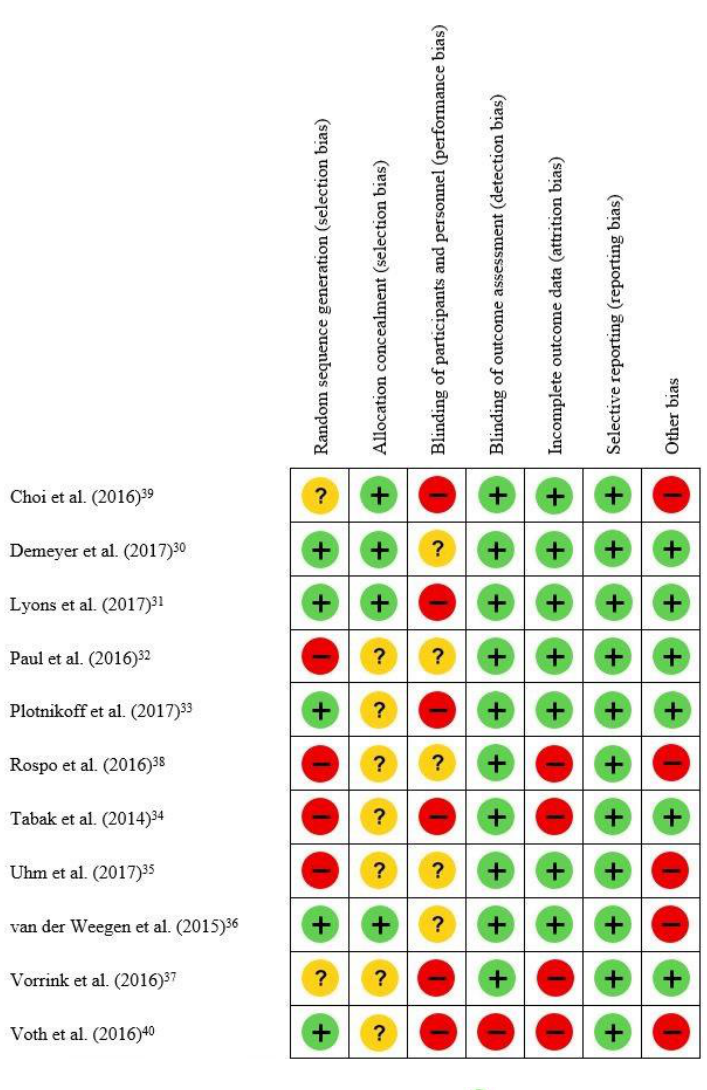
Figure 2. Risk of bias of the included studies (n=11). Legend: - Low risk of bias; - high risk of bias; - Unclear risk of bias.